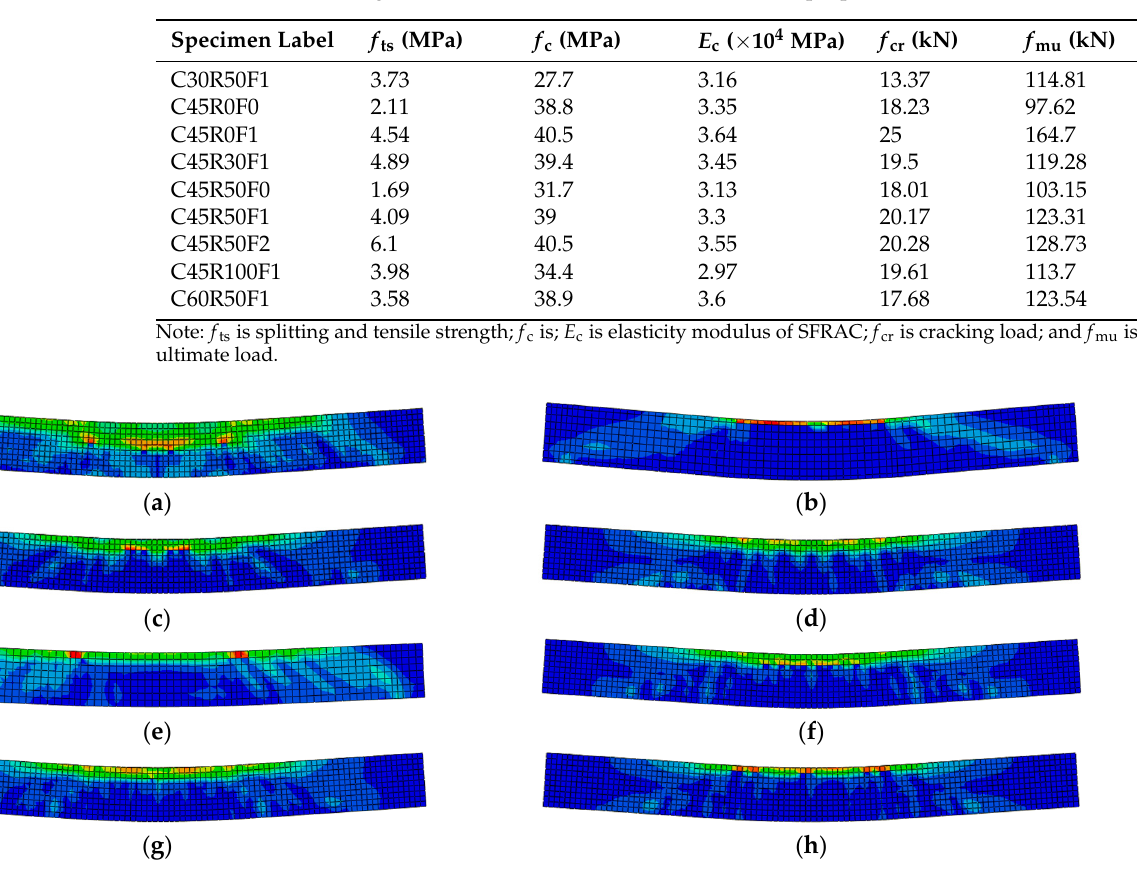
Figure 6. The damage diagram of SFRAC beams. ( a ) C30R50F1, ( b ) C45R0F1, ( c ) C45R50F0, ( d )